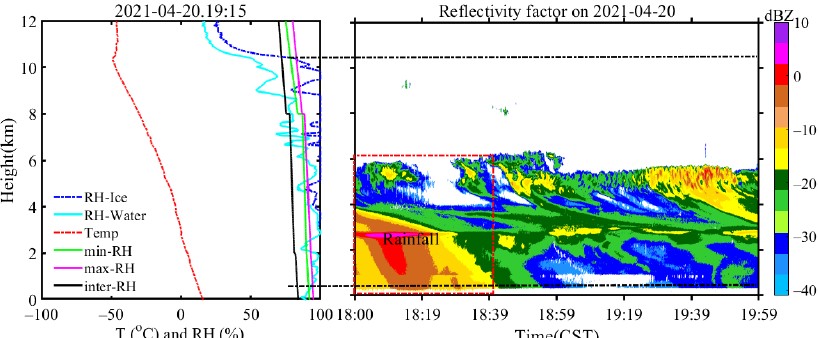
Figure 8. Non-precipitation cloud detected by the radiosonde and MMCR on 20 April 2021 (radiosonde temperature and RH profile ( left ), reflectivity factor THI from the MMCR ( right )). (Red box indicates rainfall period detected by microwave radiometer.)